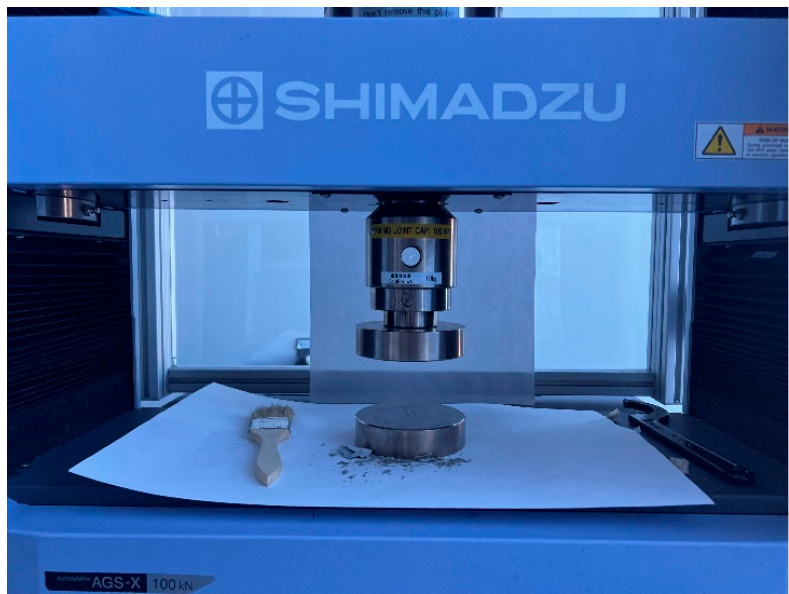
Figure 1. Universal testing machine compression test setup.